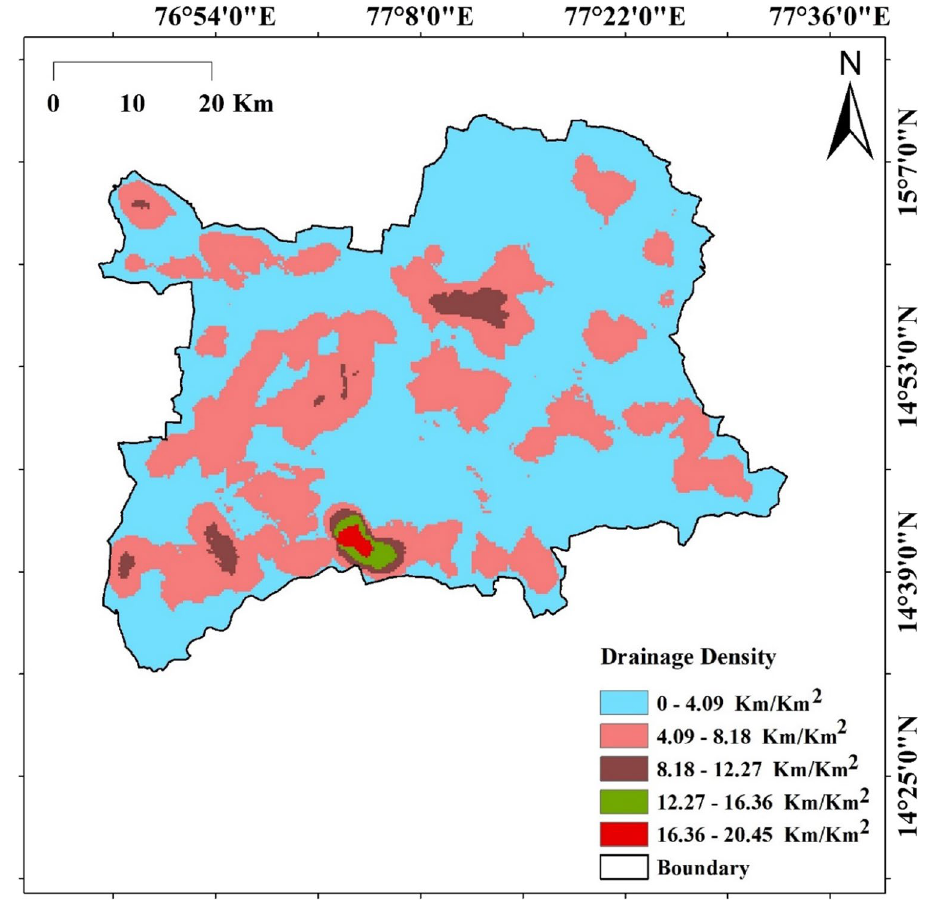
Fig. 6 Drainage density